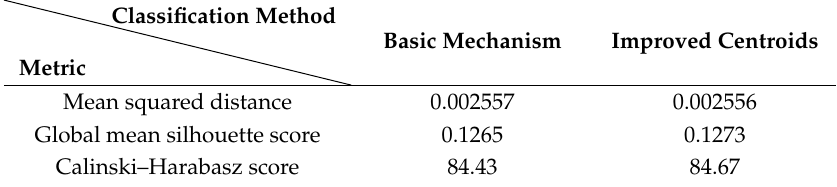
Table 5. Comparison of the classification results with different classification